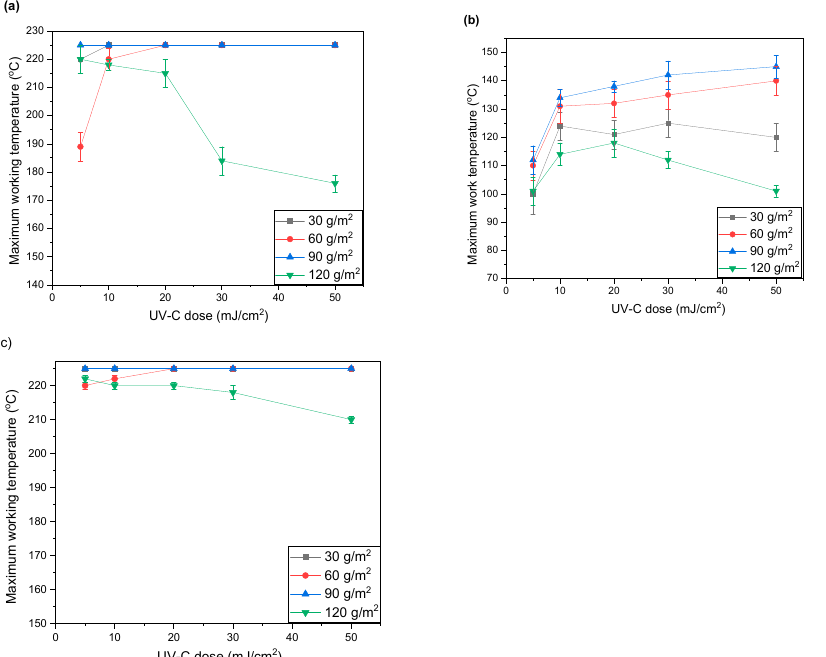
Figure 8. Maximum work temperature of tapes for self-adhesive tapes obtained from acrylate copolymers ( a ) from P1 synthesis, ( b ) from P2 synthesis, and ( c ) from P3 synthesis.